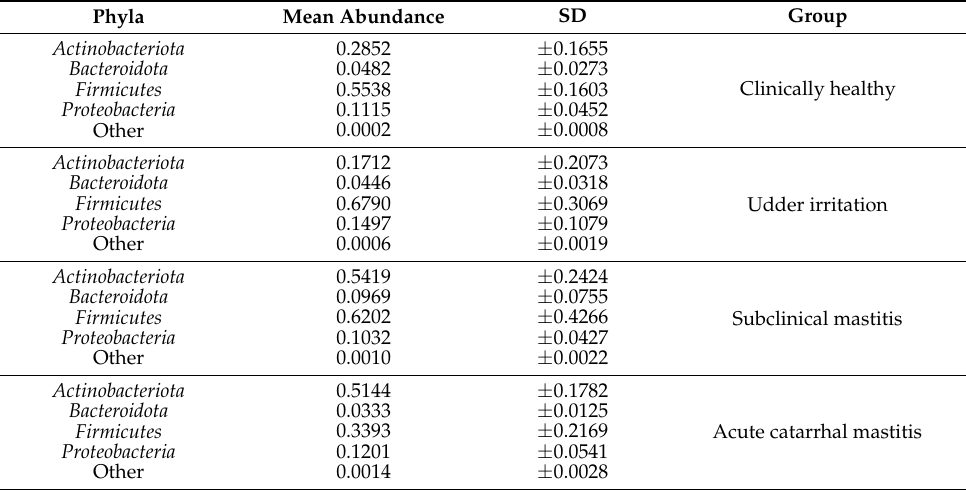
Table 3. Relative abundance of bacterial phyla in the studied